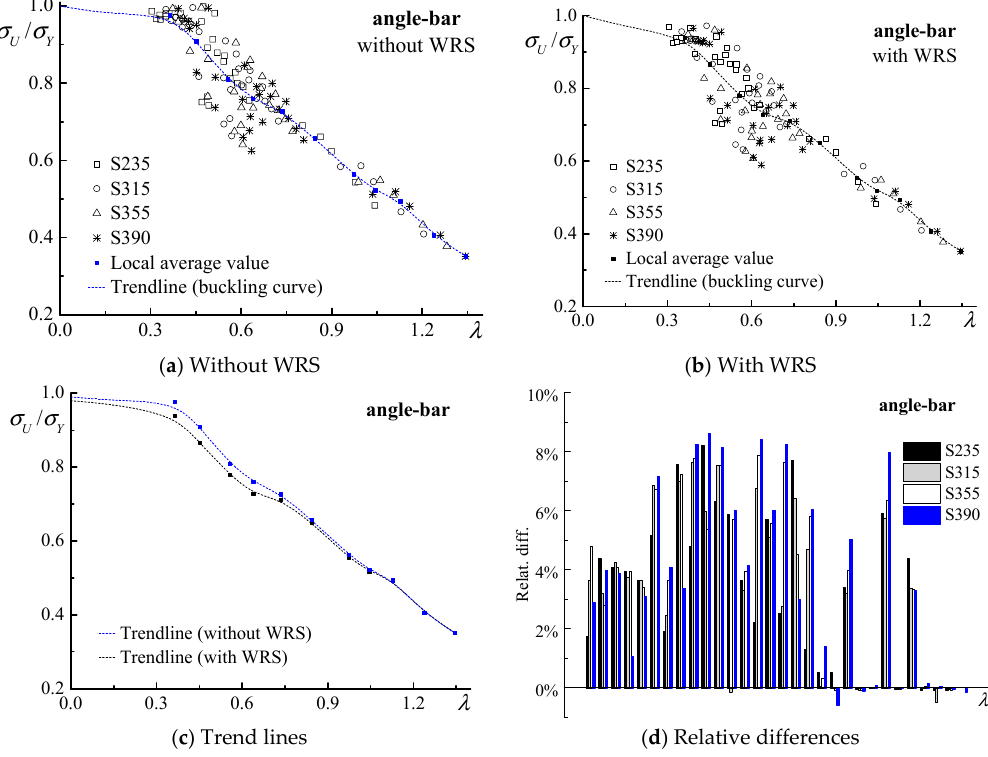
Figure 9. Ultimate strength of angle-bar stiffened plates versus column slenderness ratio.